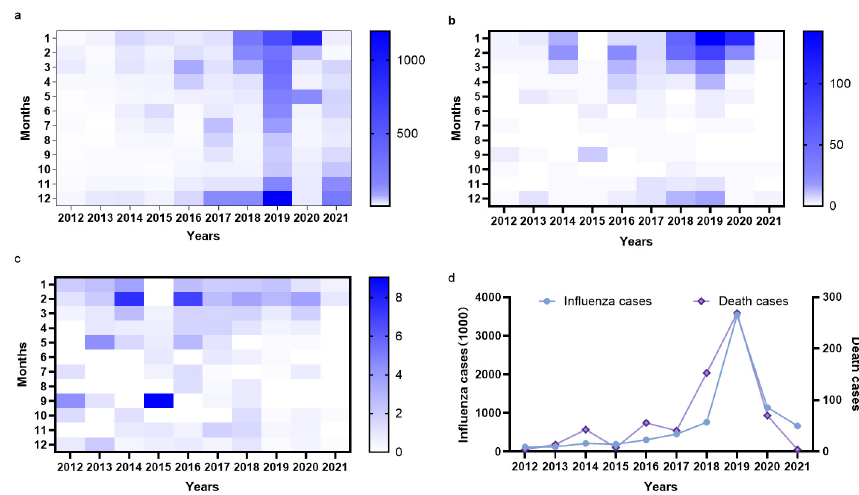
Figure 1. The numbers of influenza infections and related deaths in China. ( a ) Influenza cases (1000), ( b ) influenza deaths, ( c ) influenza case fatality rate (/10,000), ( d ) statistical results for annual influenza infections and related deaths (data were obtained from the Bureau of Disease Prevention and Control) [20].